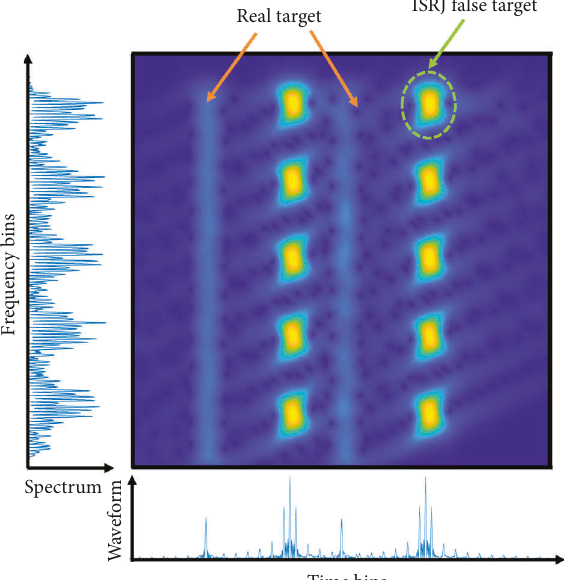
Figure 2: The TF distribution of the echo signal after PC. The main graph shows the TF distribution of the PC result, and the corre- sponding PC result in the time domain and the frequency domain is shown below and to the left of the main graph, respectively. There are two real targets with self-protection jammers, and the inter- cepted radar signal is forwarded